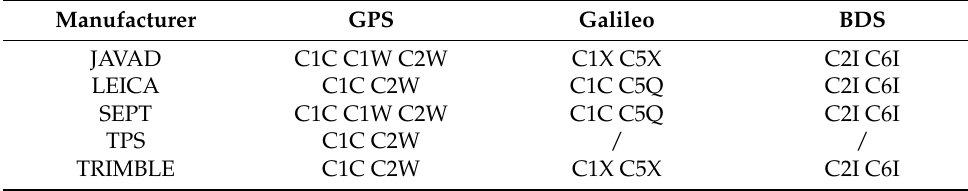
Table 2. Signal types with RINEX v3.04 used for SDB analyses.